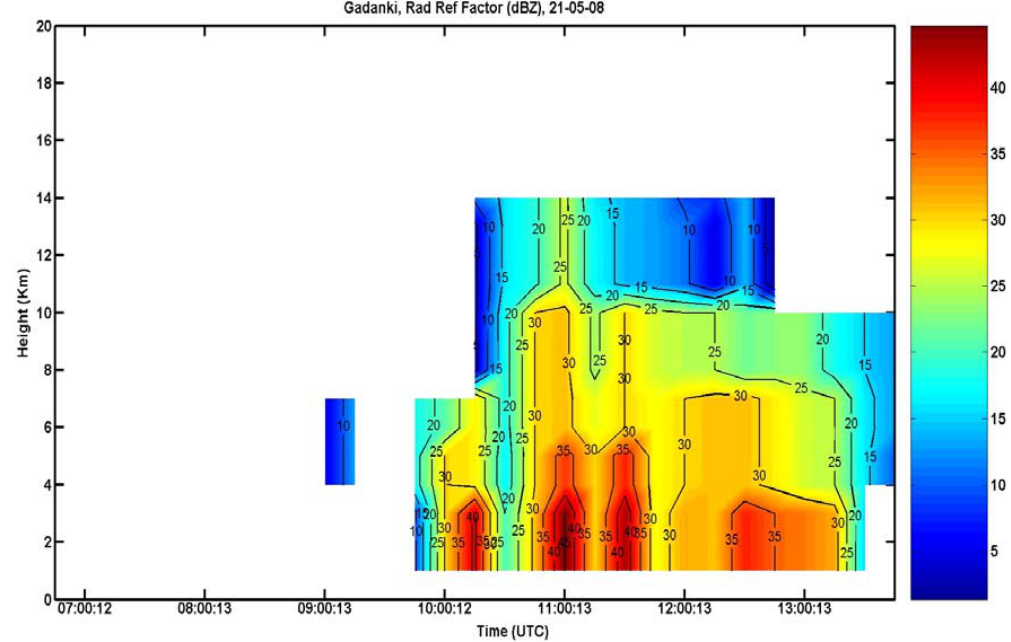
Fig. 4b. Vertical profile of reflectivity (dbz) at Gadanki on 21 May 2008 measured by the Doppler Weather Radar (DWR) at